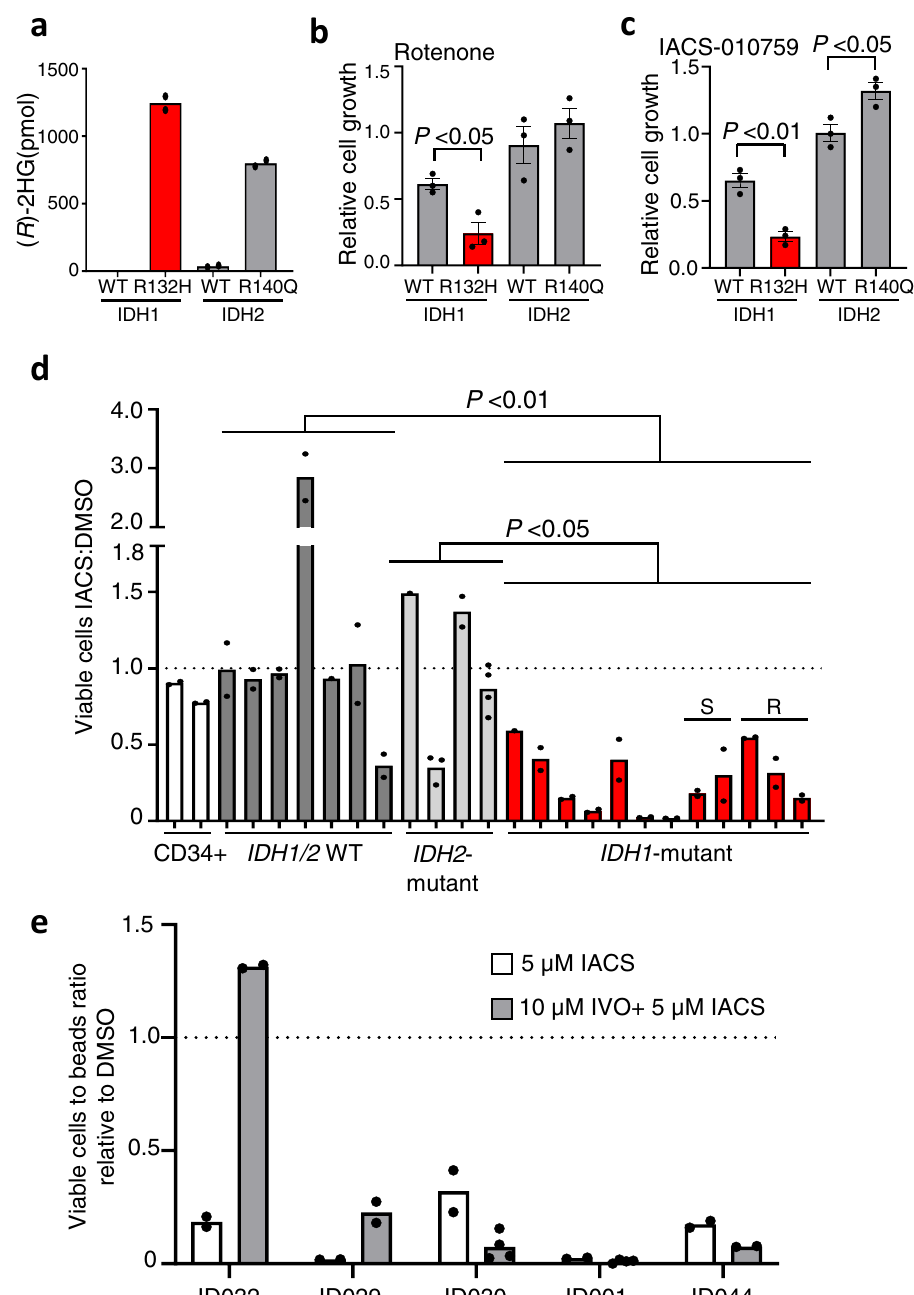
Fig. 3 IDH1 mutation confers sensitivity to complex I inhibition. a (R)-2-hydroxyglutarate (2HG) abundance in supernatants from THP-1 cells transduced with doxycycline-inducible IDH1-wild type (WT), IDH1 R132H, IDH2-WT, or IDH2 R140Q. Bars represent mean of technical duplicates from a single experiment. Data points for IDH1 -WT were below background and thus, are not represented in the graph. b and c Cell growth of GFP + doxycycline- inducible IDH1 -WT, IDH1 R132H, IDH2 -WT or IDH2 R140Q expressing THP1 cells at 72 h after treatment with ( b ) 1 µ M rotenone or ( c ) 5 µ M IACS-010759, relative to DMSO vehicle control. Bars represent mean ± SEM from three independent experiments. Each dot represents the mean of an independent experiment. Statistical signi fi cance determined by two-tailed unpaired t -test. Signi fi cance values for ( b ) P = 0.0146 (IDH1-WT vs. IDH1 R132H), and ( c ) P = 0.0028 (IDH1-WT vs. IDH1 R132H) and 0.0246 (IDH2-WT vs. IDH2 R140Q). d Ratio of live (propidium iodide-negative) cells for healthy CD34 + samples ( n = 2), IDH1/2 WT ( n = 7), IDH2 - ( n = 4) or IDH1 -mutant ( n = 12) AML samples treated with 5 µ M IACS-010759 (IACS), relative to DMSO vehicle control over 72 h. Samples tested for response to ivosidenib in Supplementary Fig. 5 are shown as S, sensitive or R, resistant to ivosidenib. Values represent mean for each sample in a single experiment and each dot is a data point. Signi fi cance determined for patient groups using one-way ANOVA (Tukey ’ s multiple correction), P = 0.0033 (IDH1/2 WT vs. IDH1 mutant), 0.0396 (IDH1 mutant vs. IDH2 mutant). e Variable response of IDH1-mutant samples treated for 72 h with 5 µ M IACS-010759 (IACS) following 24 h pre-treatment with 10 µ M ivosidenib (IVO) compared to IACS alone. Data presented relative to DMSO control. Data show mean of a single experiment and each dot represents a data point. Details of patient samples used in d-e are provided in Supplementary Data 5. Source data are provided as a Source Data fi